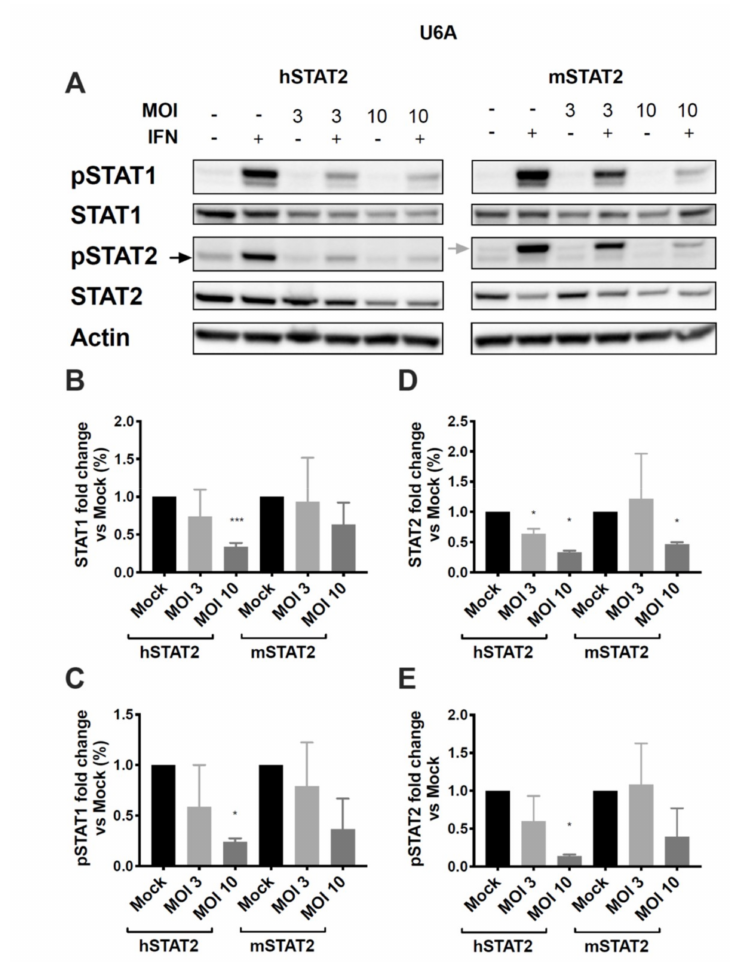
Figure 6. Expression of human STAT2 promotes STAT1 and STAT2 inhibition, while murine STAT2 inhibits STAT degradation. STAT2-deficient U6A cells were transfected with hSTAT2 or mSTAT2, then infected with HMPV. Cells were treated with IFN 16 h after infection for 40 min before cell lysis and protein harvesting for Western blotting. ( A ) STAT1 and STAT2 expression and phosphorylation in U6A cells in the presence of human or murine STAT2. ( B – E ) Quantification of band intensity as a measure of fold change in U6A cells for total STAT1 ( B ), pSTAT1 ( C ), total STAT2 ( D ), and pSTAT2 ( E ). * p < 0.05, *** p < 0.001, one sample t test against normalized mock value of 1. Data are representative of ( A ) or combined from ( B – E ) two independent